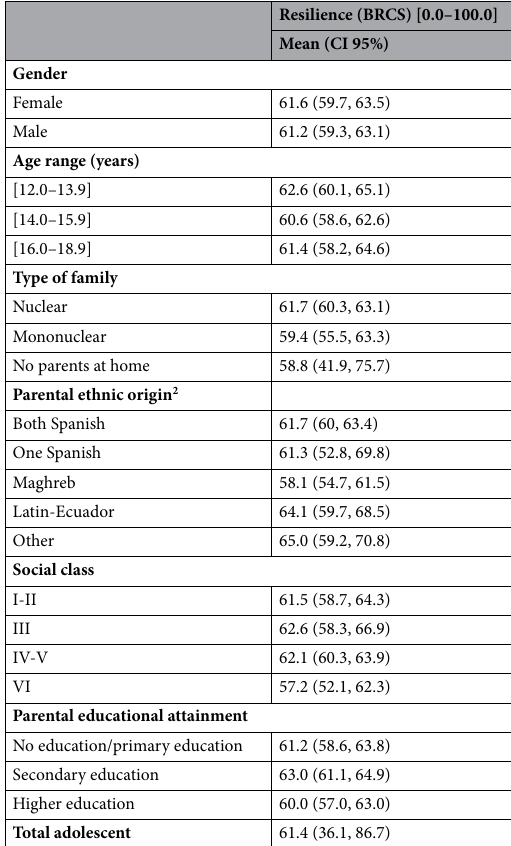
Table 2. Descriptive analyses of adolescents’ resilience according to sociodemographic characteristics. Null hypothesis = homogenous means (hypothesis contrast using the Oneway Analysis of Variance). * p < 0.05. Therefore, no statistically significant results were found. a. Social class: I. Higher managerial; II. Intermediate managerial; III. Supervisory and junior managerial; IV. Skilled manual occupations; V. Unskilled manual occupations; VI.